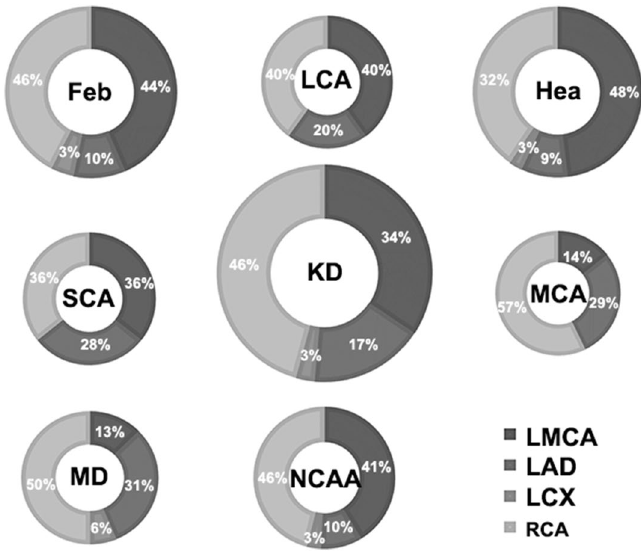
Figure 2. Coronary segment distribution of the preZmax in different groups. The number shows the percentage of coronary segment which the preZmax came